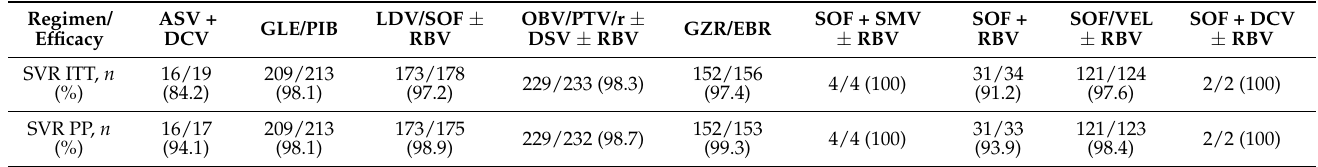
Table 4. Treatment Efficacy According to Therapeutic